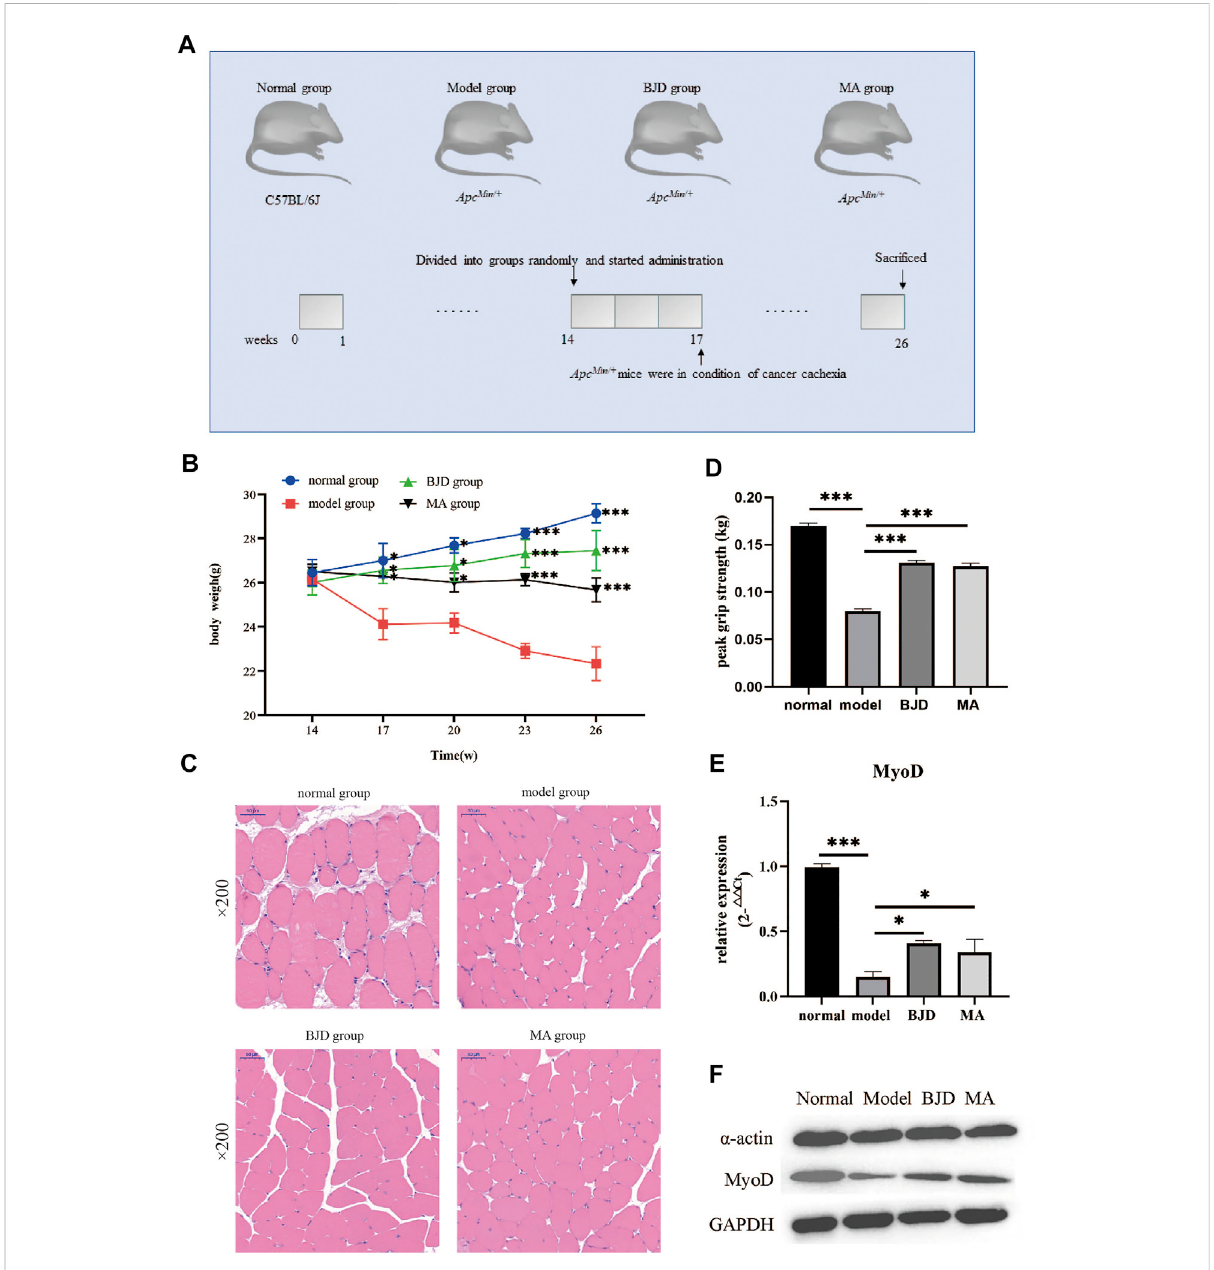
BJD relieved Apc Min/+ mice muscle atrophy. (A) Diagram presenting the mouse experiments. (B) The changes in body weight of each group; (C) thepictures of the gastrocnemiusmuscle stained by H&E (×200 magni fi cation;scale bar: 50 µm); (D) the changes in grip strength of each group; (E) the relative expressions of MyoD detected by qPCR, with ß -actin used as an internal gene; and (F) the expressions of a -actin and MyoD by western blotting,withGAPDHusedasaloadingcontrol.Thedataarepresentedasthemean±SD.Comparedwithmodelgroup,* p < 0.05,*** p <